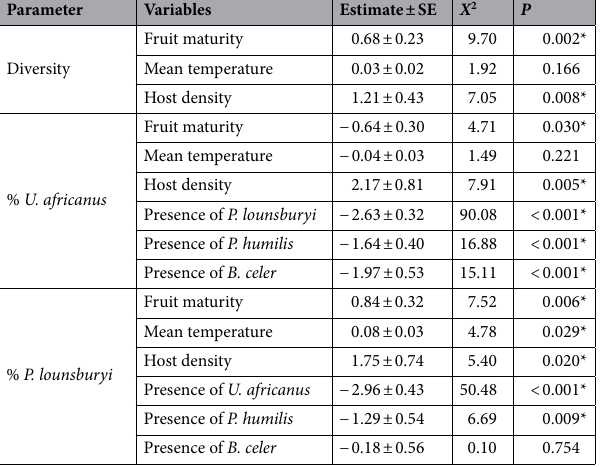
Table 4. Generalized Linear Model testing the effects of (1) fruit maturity (unripe vs. ripe), mean monthly temperature and host density (= % fruit infested) on diversity of braconid parasitoids, and (2) fruit maturity, mean monthly temperature, host density, and incidence of other braconids on the relative abundance of the dominant braconids U. africanus or P. lounsburyi in Western Cape, South